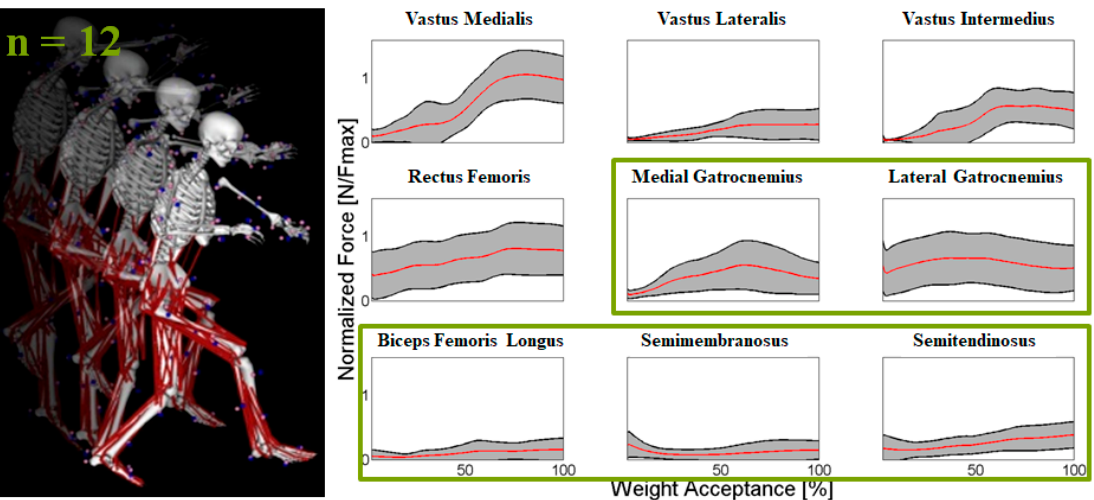
Figure 4. Overview of individual lower limb muscle contributions during single-leg landing.